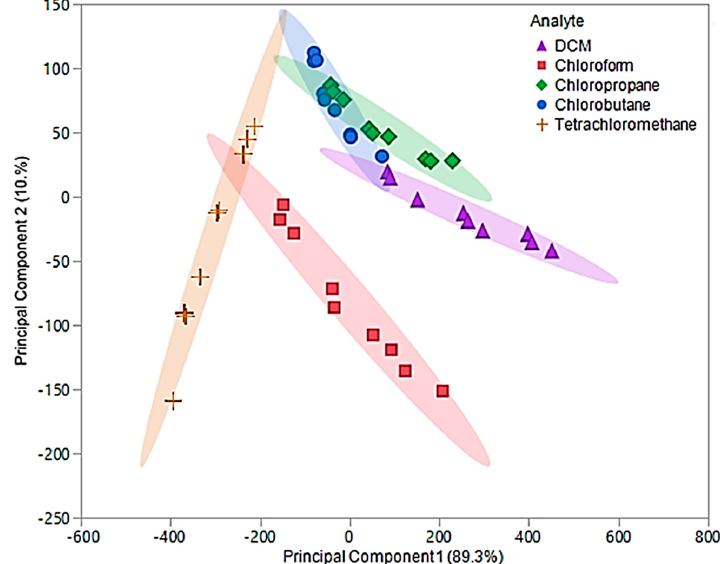
Figure 9. Principal component plot for discrimination of five chlorinated VOCs with respect to a three sensor MSA. The plot considers 45 total measurements consisting of three replicate measurements at three different flow ratios for each VOC (nine measurements per sample) using composite sensors.